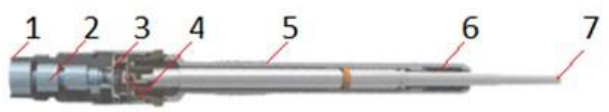
Fig. 7. The components of the glow plug from the Opel Insignia 2014 2.0 CDTi engine. Source: own elaboration. 1 – caulked nut, 2 – high voltage